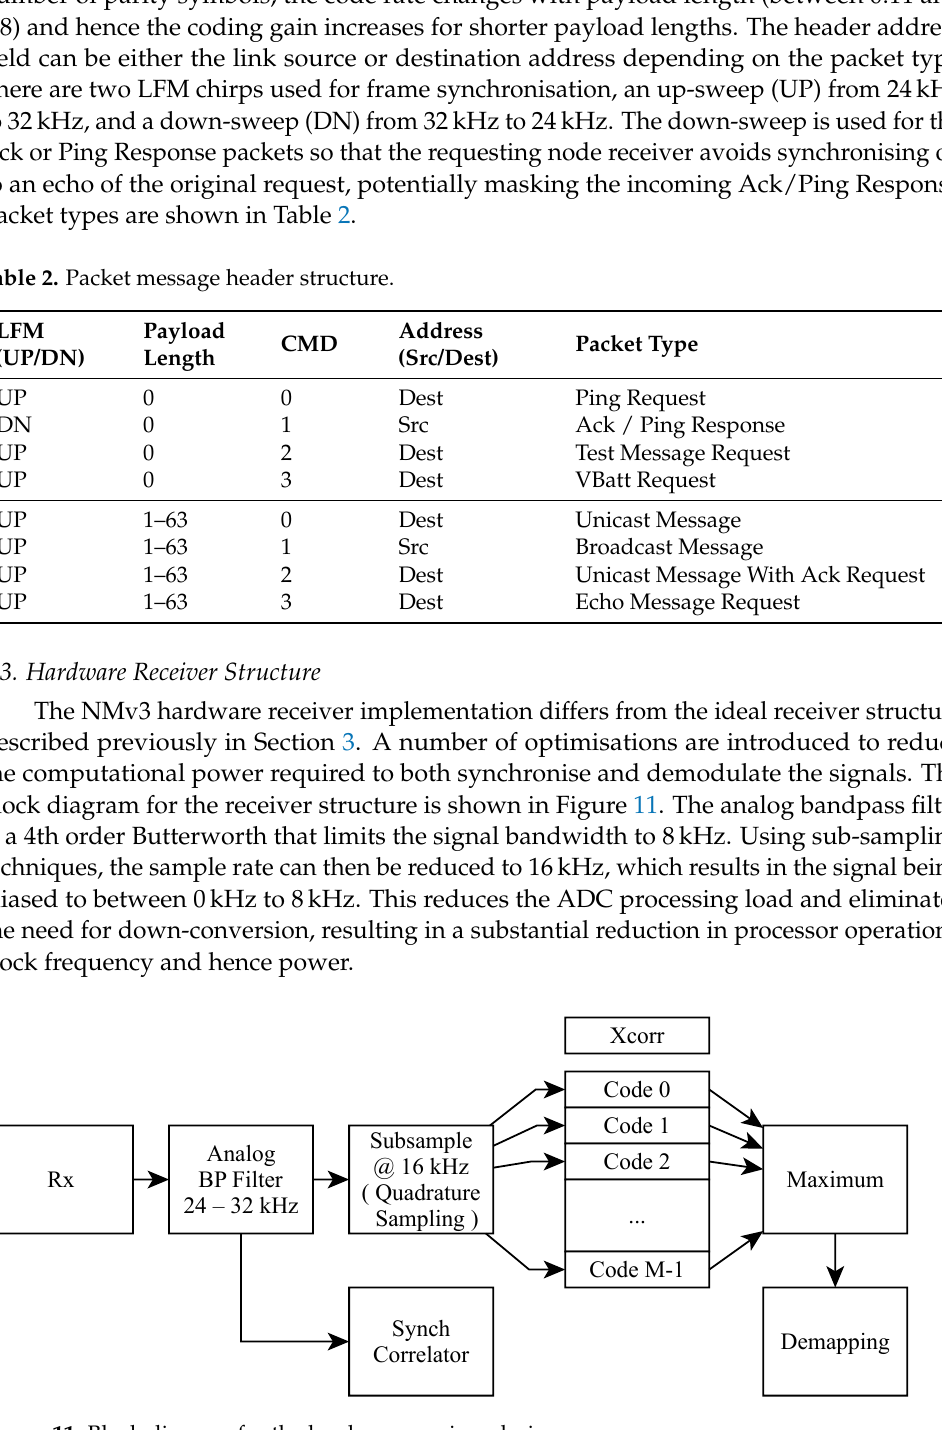
Figure 11. Block diagram for the hardware receiver